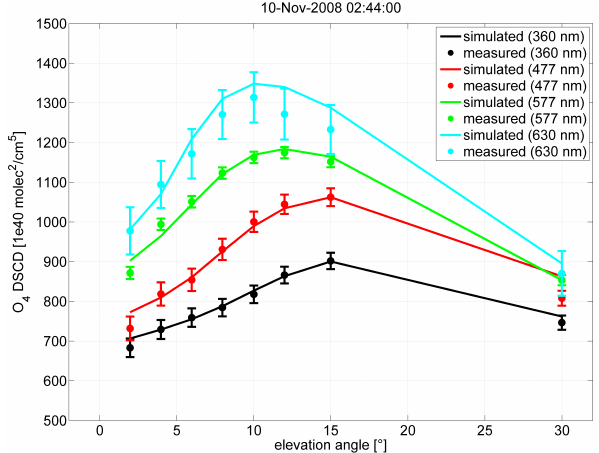
Fig. 7. Comparison between measured O 4 DSCDs, on 10 Novem- ber 2008 at 02:44UTC, and the DSCDs simulated using the LI- DORT radiative transfer code with the retrieved aerosol extinction vertical profiles as input. Error bars shown are the O 4 DSCDs DOAS fit